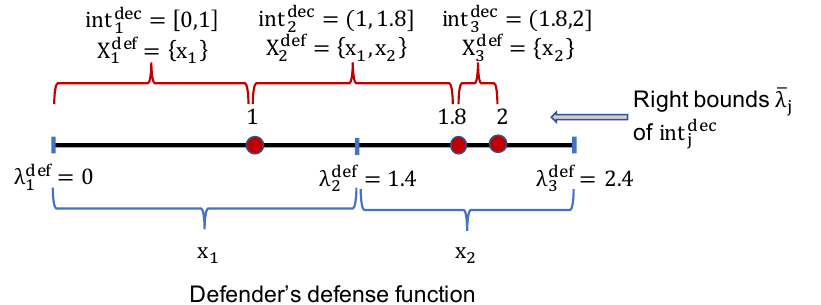
Figure 2. An example of a defense function with corresponding sub-intervals and uncertainty sets of the attacker, where λ max = 2.0 and δ = 0.4. The defense function is determined as: I d = ( 1.4,2.4 ] with corresponding defense strategies { x I d 2 attacker can be divided into three sub-intervals: int dec with corresponding uncertainty sets X def attacker plays any λ dec ∈ int dec